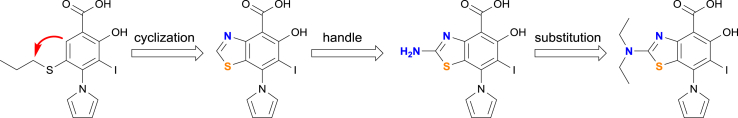
Design strategy towards substituted aminobenzothiazole derivatives.